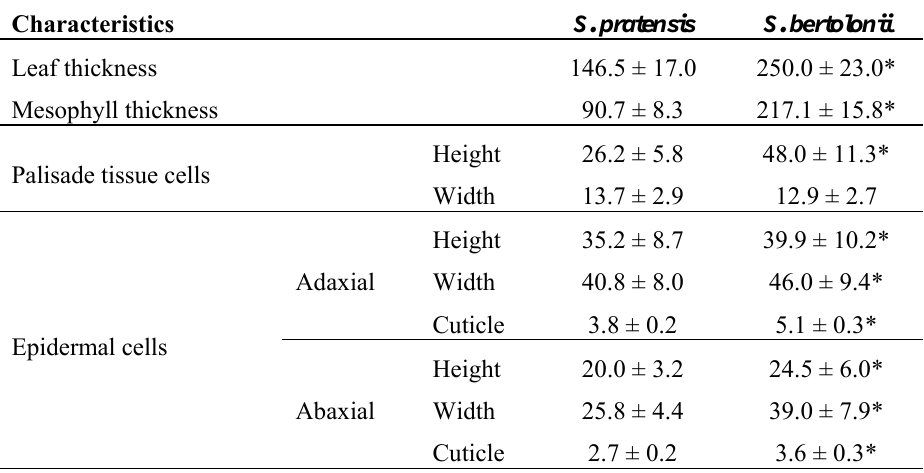
Table 2a. Leaf anatomy characteristics a of S. pratensis and S. bertolonii.